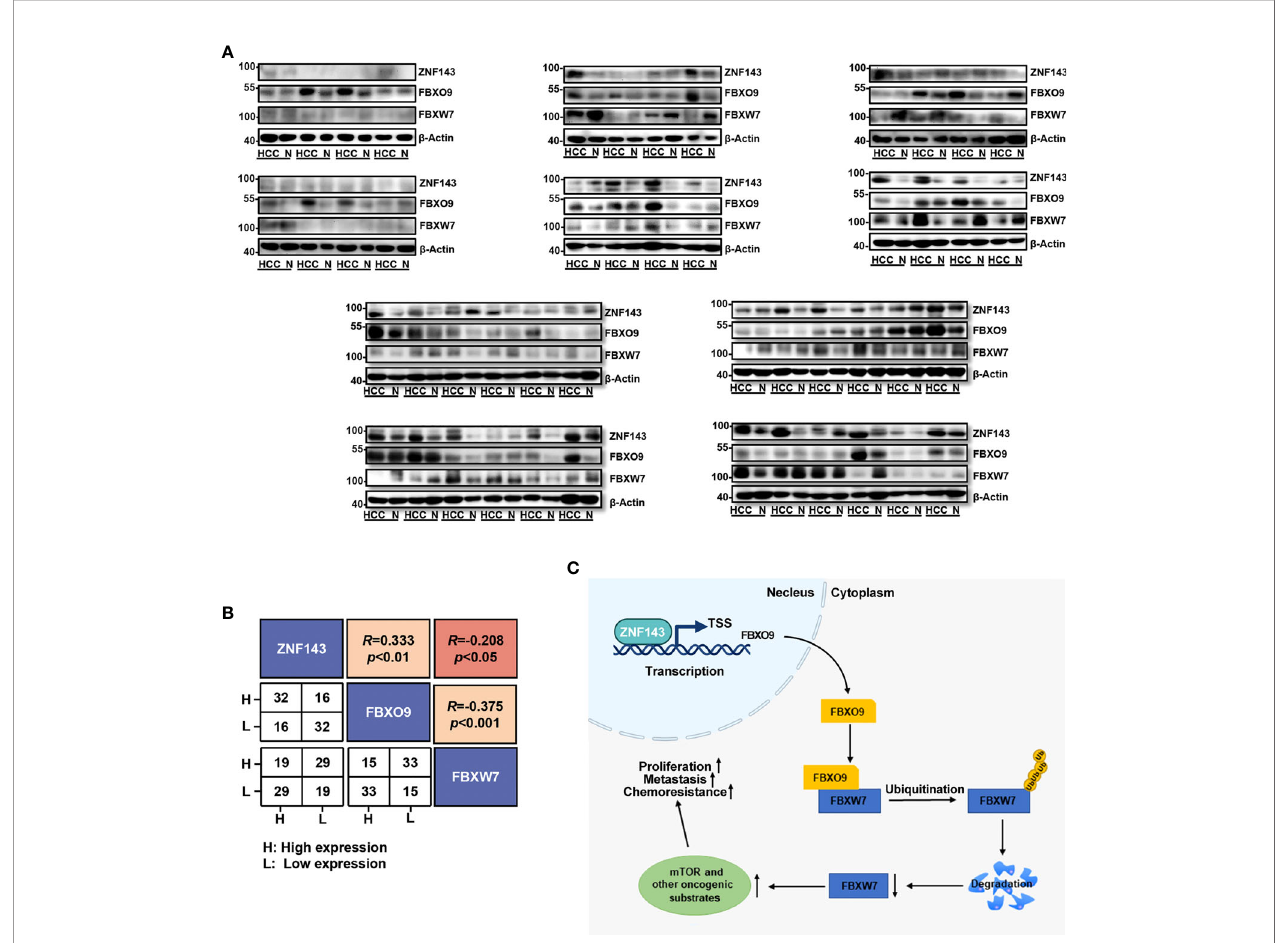
FIGURE 7 | Correlation of ZNF143, FBXO9 and FBXW7 in HCC samples. (A) Western blotting analysis of FBXO9, ZNF143, and FBXW7 expression in HCC and paired noncancerous tissues (N). (B) Correlation analysis of ZNF143, FBXO9, and FBXW7 expression trends shown in Western blotting analysis of panel (A) . (C) Pattern diagram of the ZNF143-FBXO9-FBXW7 axis. Under the transcriptional regulation of the ZNF143, FBXO9 directly interacts with FBXW7 and induces ubiquitination and degradation of FBXW7 and thus leads to an increase in oncogenic substrates of FBXW7, which ultimately promotes the progression and drug resistance of HCC. R, Pearson correlation coef fi